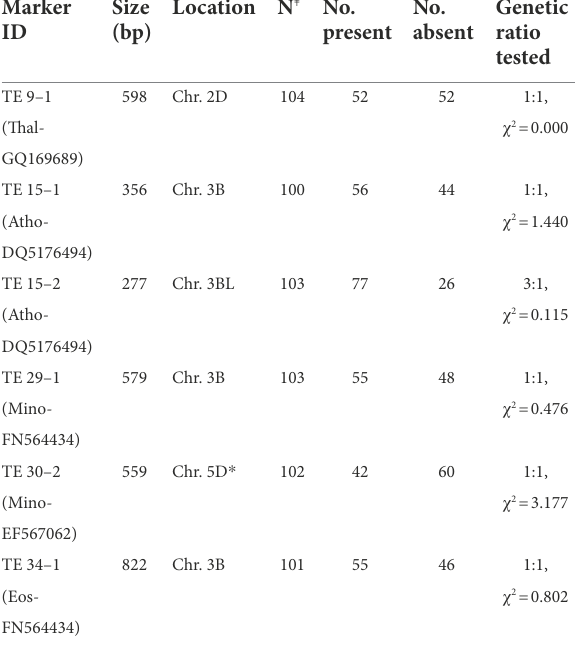
TABLE 4 MITE marker identity, size, chromosomal location, and segregation ratio tested in a Chinese Spring (P 1 ) × SHW ABD No.4 (P 2 ) RIL mapping population. Marker